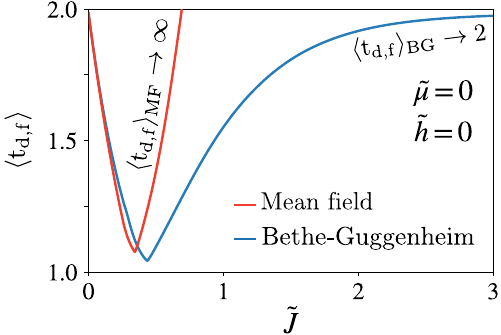
18. Mean dissolution or formation time in the thermody- namic limit: Bethe-Guggenheim versus mean field approxima- tion. The Bethe-Guggenheim approximation is given by Eq. (E26), and the mean field approximation is given by Eq. (E35), where we solve for Eq. (E31)